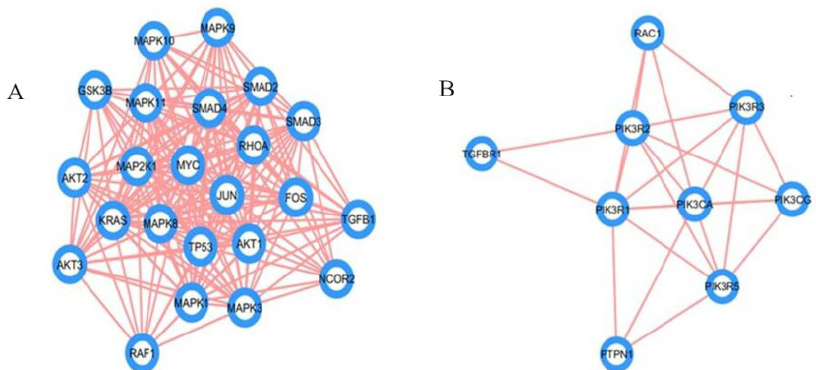
Figure 1. MCODE clustering of miR-122 interactors. ( A ) Largest cluster with twenty-three genes; ( B ) Second largest cluster with nine genes.